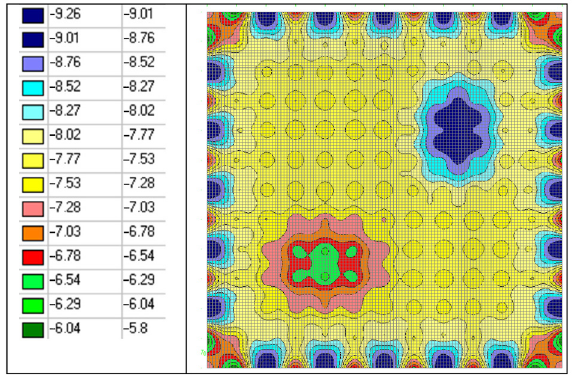
Fig. 14. Settlements of the slab ( mm ). The majority of piles are 47.5 MN/m; area A with pile stiffness of 57.0 MN/m, area B with pile stiffness of 38.0